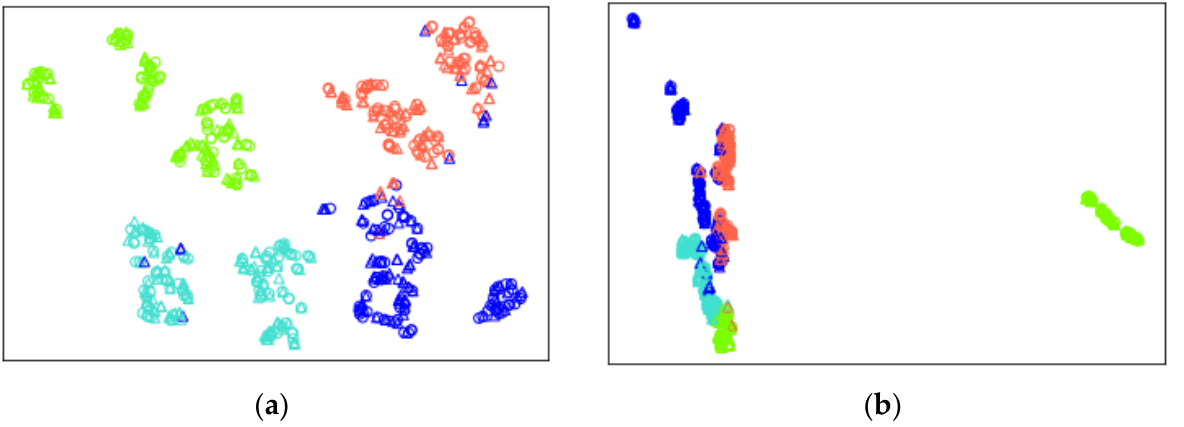
Figure 12. The visualization results of the learned features using different methods for task T2. The different colors represent different athletes; balance control ability levels: ( a ) the result of our proposed method; ( b ) the result of the DNN method.